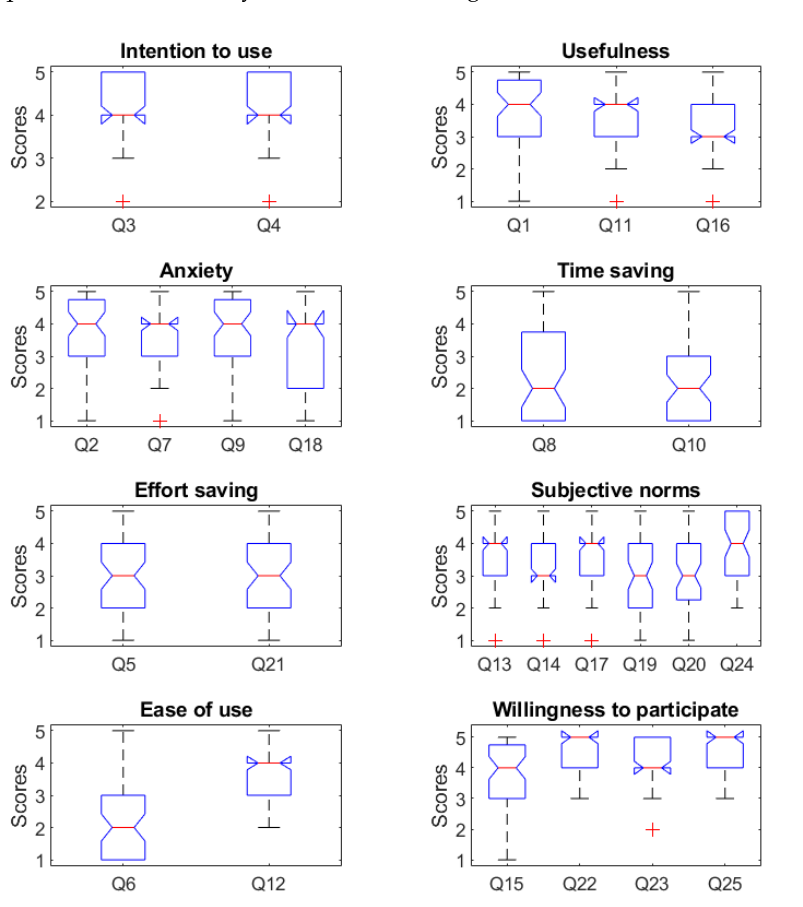
Figure 3. Statistical analysis of the scores given by the 55 users to the questions. Question numbers correspond to those indicated in Appendix A.1. We gathered the questions by category. In each box plot, the central mark indicates the median, and the bottom and top edges of the box indicate the 25th and 75th percentiles,